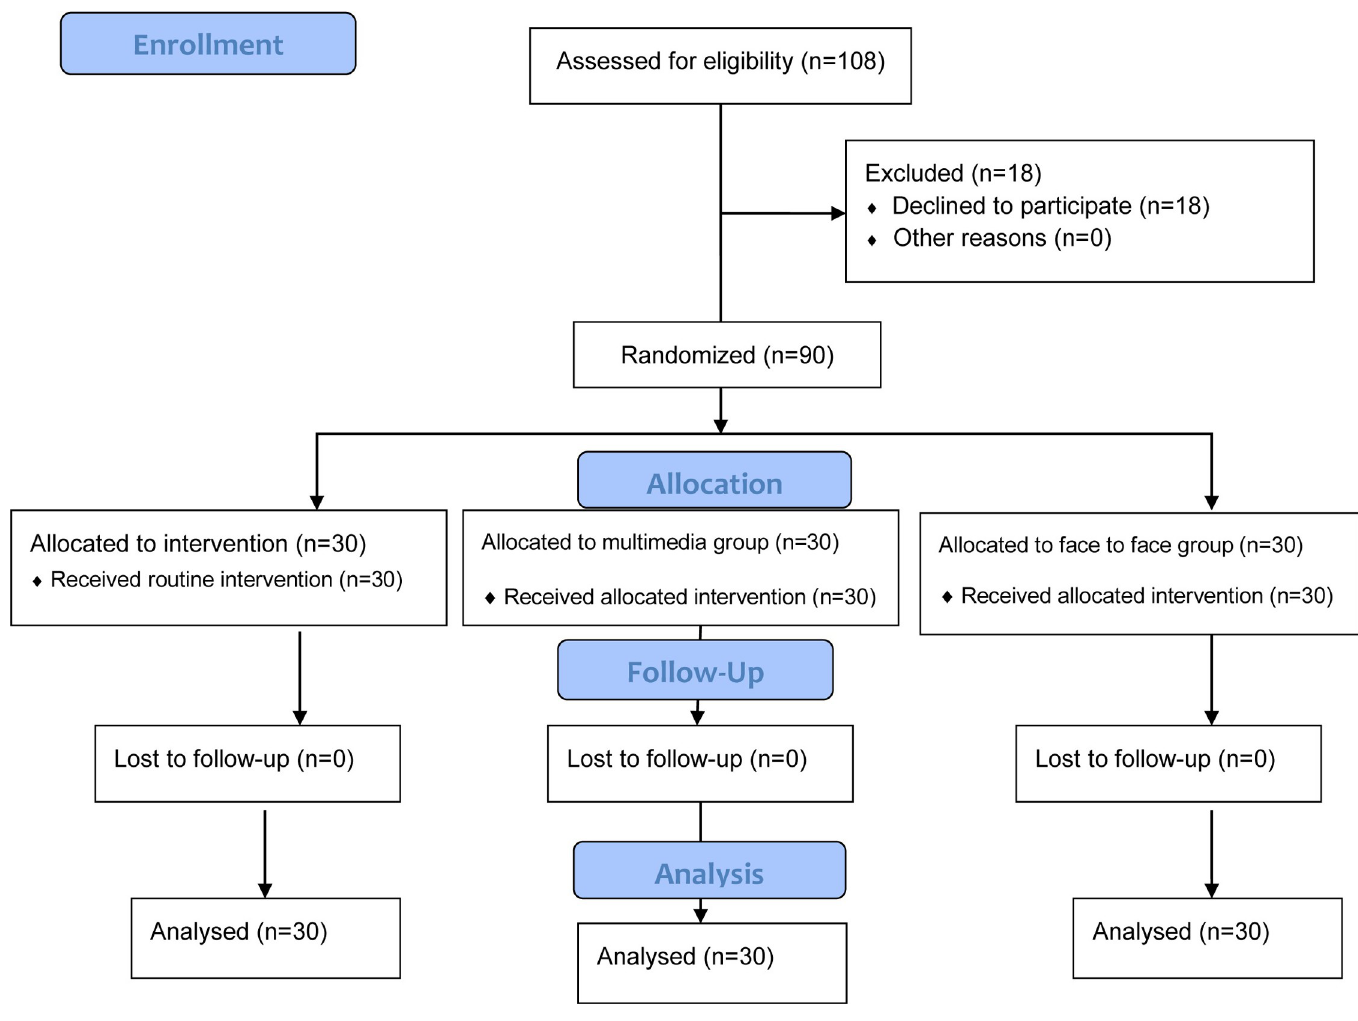
Fig 1. CONSORT flow